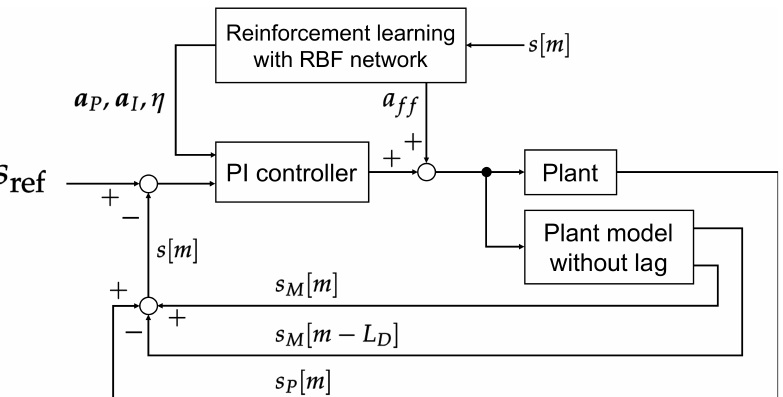
Figure 4. Proposed Smith predictor based on the two-DOF PI control system. Its feed-forward control and PI gains are tuned by the RL algorithm. We note that this figure represents the construction of a control system for a single manipulating device, but the reinforcement learning part takes care of the entire process to compensate for the interference between